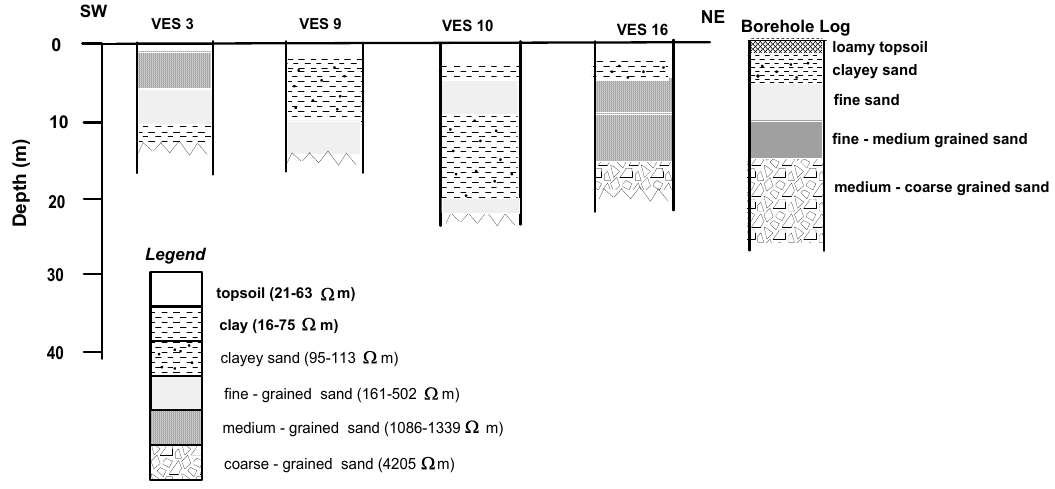
Figure 4. Geoelectric section showing VES points along the direction southwest–northeast.